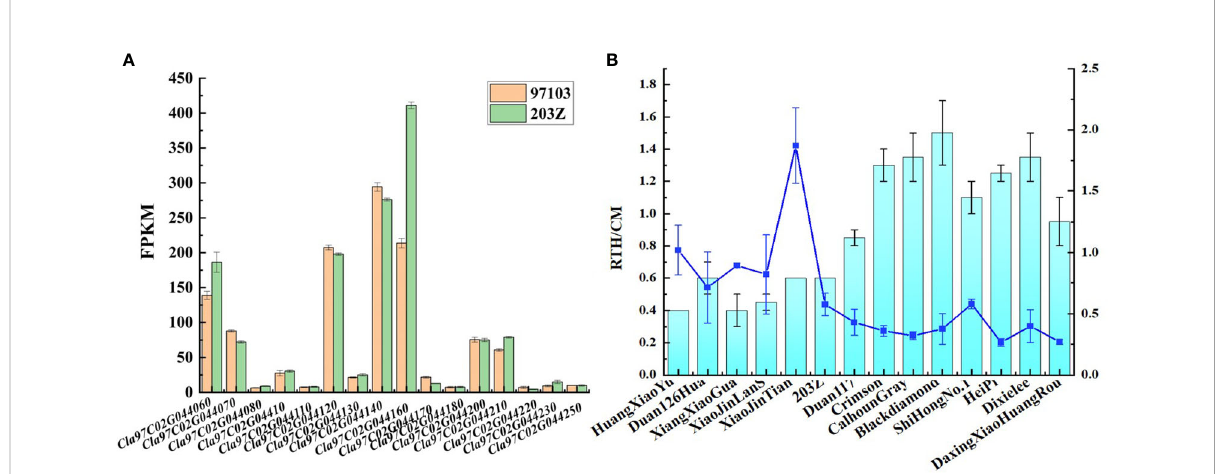
FIGURE 4 Expression levels of candidate genes for rind thickness and single fruit weight. (A) Statistical diagram of gene expression levels among ‘ 97103 ’ and ‘ 203Z ’ within the candidate interval. (B) Rind thickness and relative gene expression level of Cla97C02G044160 in 14 watermelon